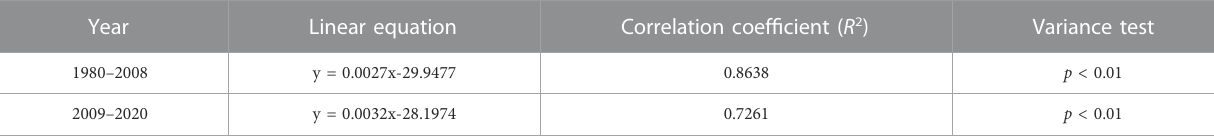
TABLE 4 Linear relationship between sediment load and rainfall erosivity at different periods in Nandu River